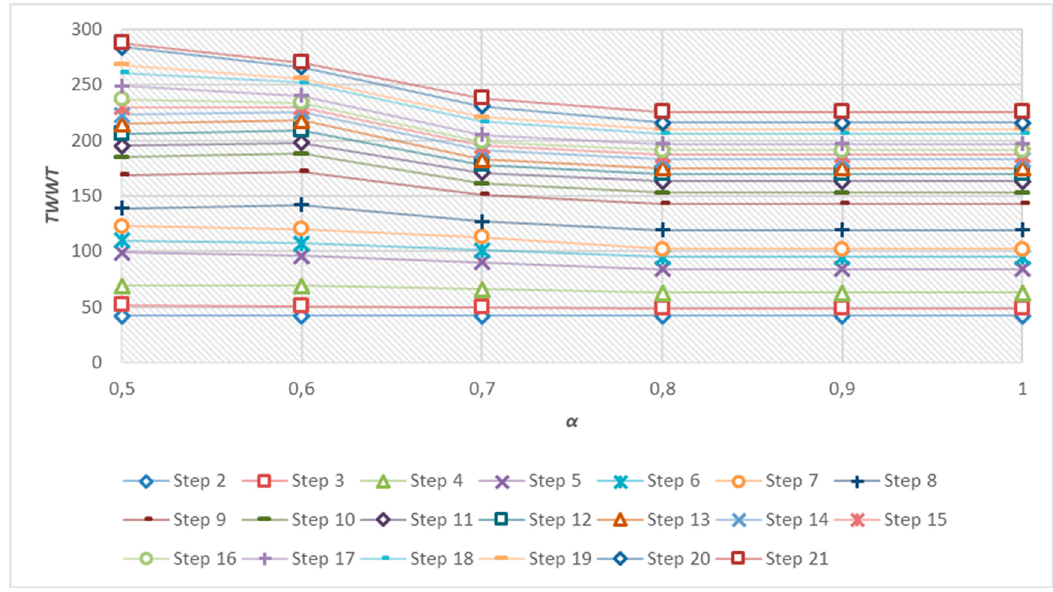
Figure 6. TWWT according to α .